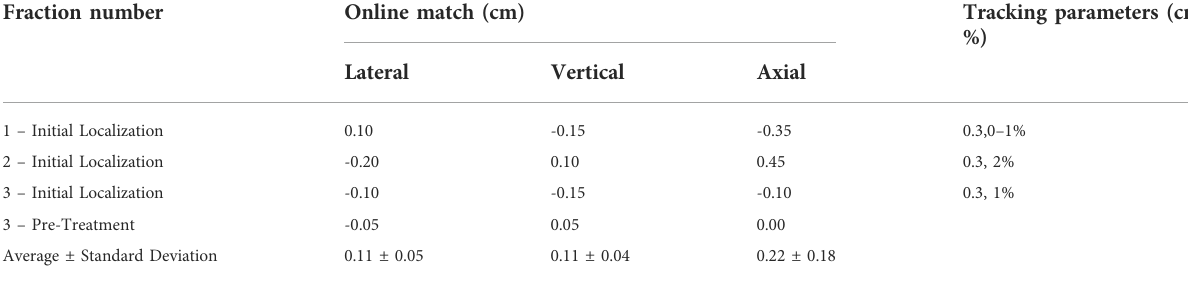
TABLE 2 Daily volumetric imaging shifts for the initial patient setup and pre-treatment localization images, as well as the tracking parameters